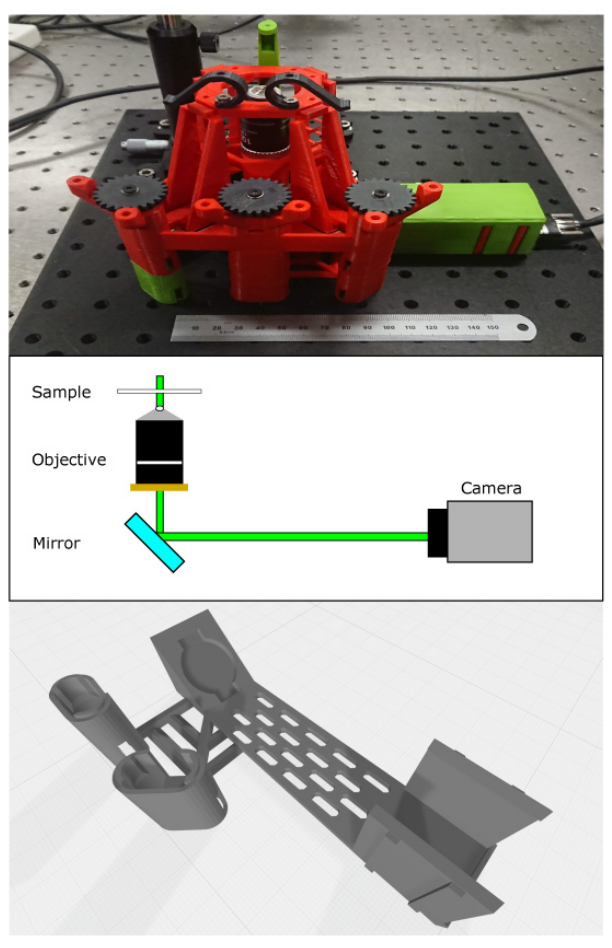
Figure 1. Layout of microscope. Top - image of microscope as constructed. It is mounted on an aluminium breadboard for portability and stability. The ruler is 15cm and shown for scale. The colours of individual parts are arbitrary. Middle - beam path showing key design parameters. Illumination is from a laser mounted above the sample and the camera is mounted at the primary imaging plane of the microscope objective with an emission filter directly attached. The turning mirror allows a more compact design. Bottom: integrated mirror and camera mount to allow imaging with high sensitivity camera. We used the slots in the base of this part to pass mounting screws to the breadboard for additional